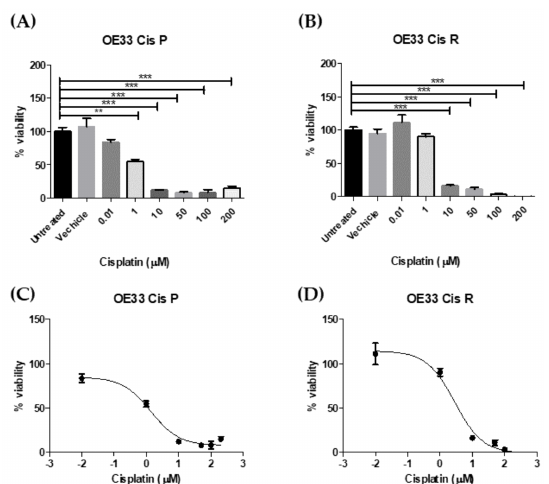
Figure 1. Oesophageal adenocarcinoma (OAC) cisplatin-sensitive (OE33 Cis P) cells were significantly more sensitive to cisplatin-induced cell death than OAC cisplatin-resistant (OE33 Cis R) cells. The toxicity to a range of increasing concentrations of cisplatin in ( A ) OE33 Cis P and ( B ) OE33 Cis R cells following 48 h of treatment was determined using a CCK-8 assay. The 48-h IC 50 for ( C ) OE33 Cis P cells and (D) OE33 Cis R cells was 1.3 µ M and 2.8 µ M, respectively (n = 3). ** p < 0.01, *** p < 0.001 by an unpaired two-tailed t